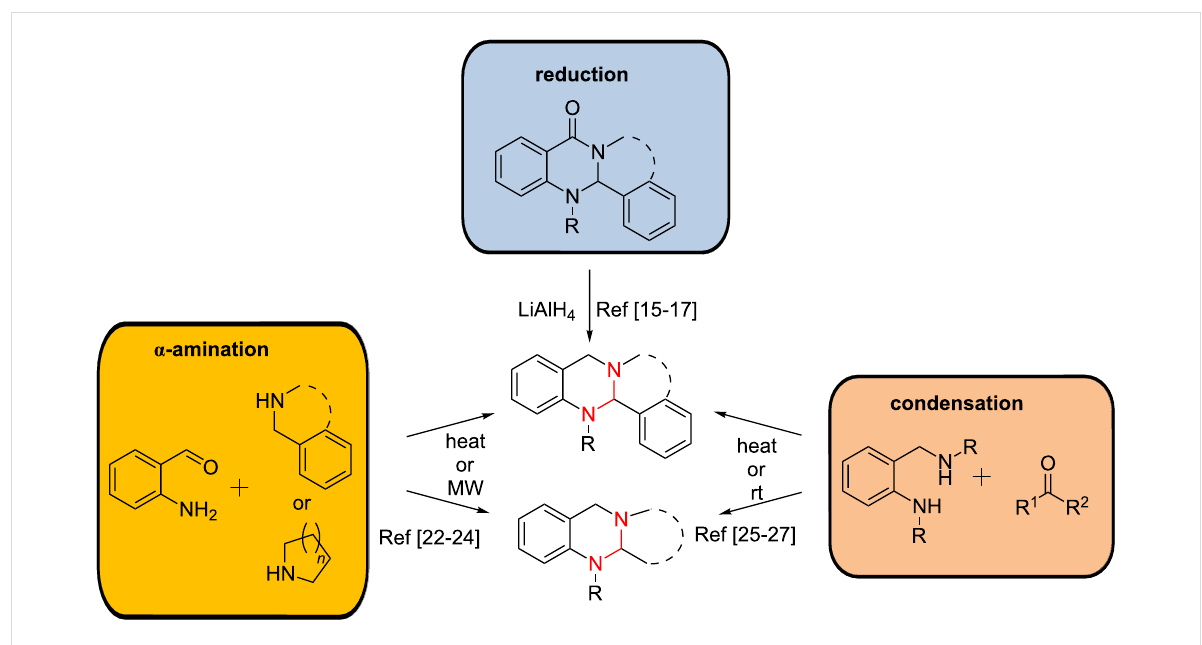
Scheme 1: Synthetic approaches for the formation of the tetrahydroquinazoline moiety. Dashed lines indicate both cyclized or non-cyclized com- pounds and the aminal structure is highlighted in